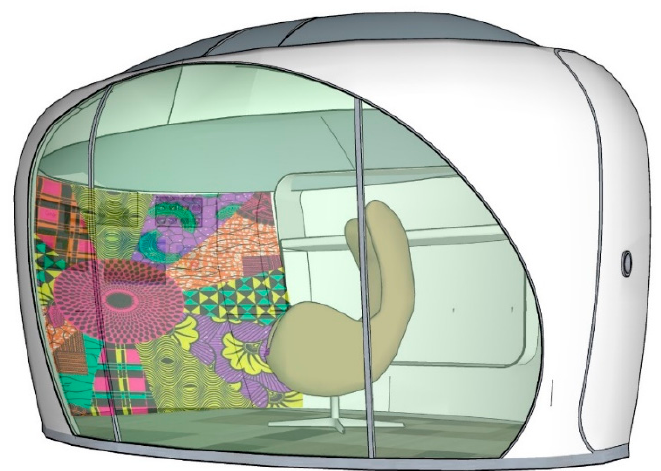
Figure 16. Pod design for Kernel of Consciousness, hyper-stimulant of the mind . The patient sits in a seat that is placed in front of a concave screen, which projects imagery that engages with different sense modalities. Olfactory and haptic sensations may also be deployed.